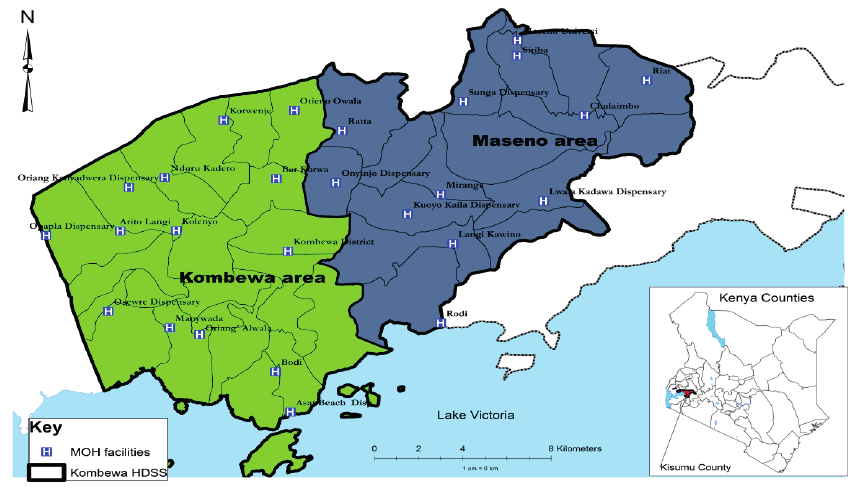
Figure 1. Location of the study